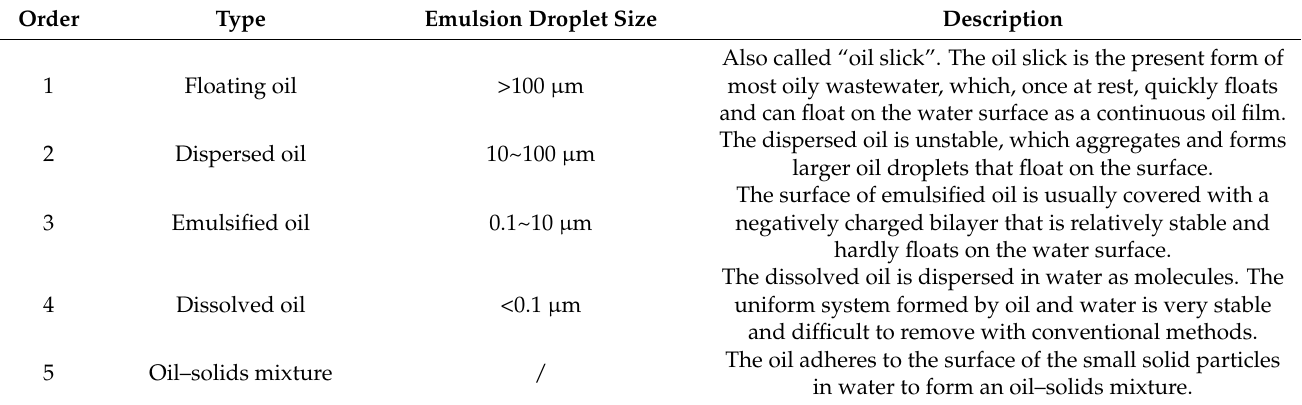
Table 7. Five types of oily